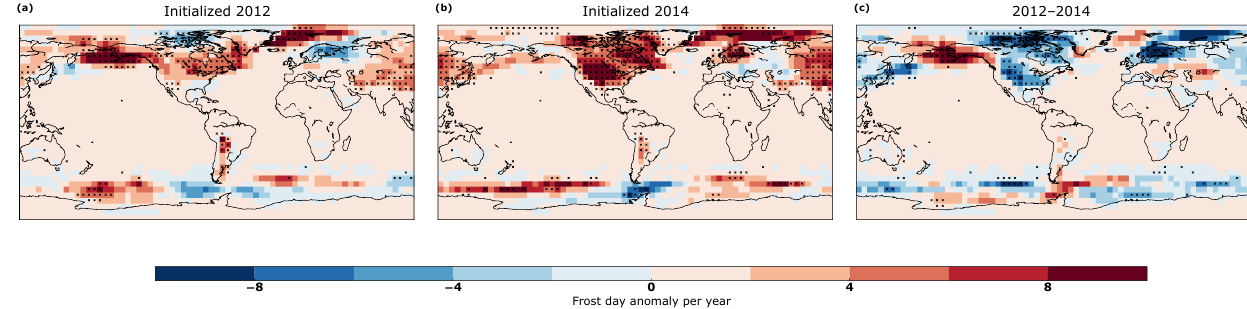
Figure 7. Differences in ensemble mean forecasts of frost days (FDs) for prediction years 1–4. (a) Exp-2012 (Pinatubo-2012 – b1-2012), (b) exp-2014 (Pinatubo-2014 – b1-2014), and (c) the difference between the two (exp-2012 – exp-2014). Crosses denote values significantly different from zero exceeding a 5%